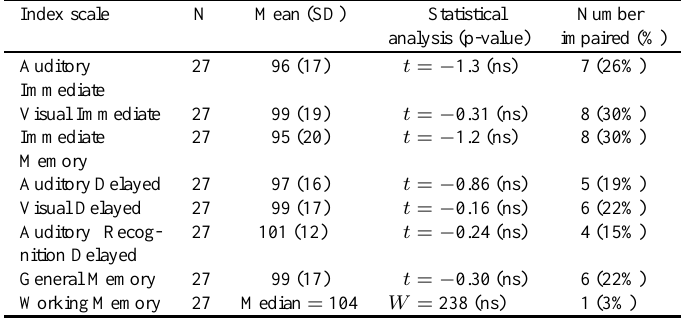
Table 2 Memory functioning of SCA6 group and comparison with control data